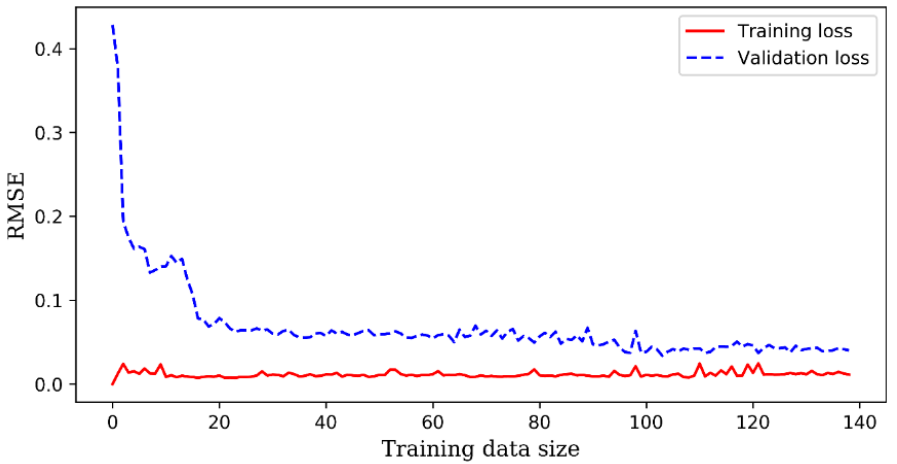
Figure 14. Learning rate curves for an ANN model at T E = 5 s in irregular waves. After training the ANN model with the training data, the conversion efficiency ( η irr ) and non-dimensional significant wave force ( ( f 1 ) / ρ gd 1 A ) on the barrier are pre- 1/3 dicted with the test data. The resulting predictions are compared with the true values. The deviation of the predicted values(circle) from the true values(line) is shown in Figure 15 and a good agreement between them is